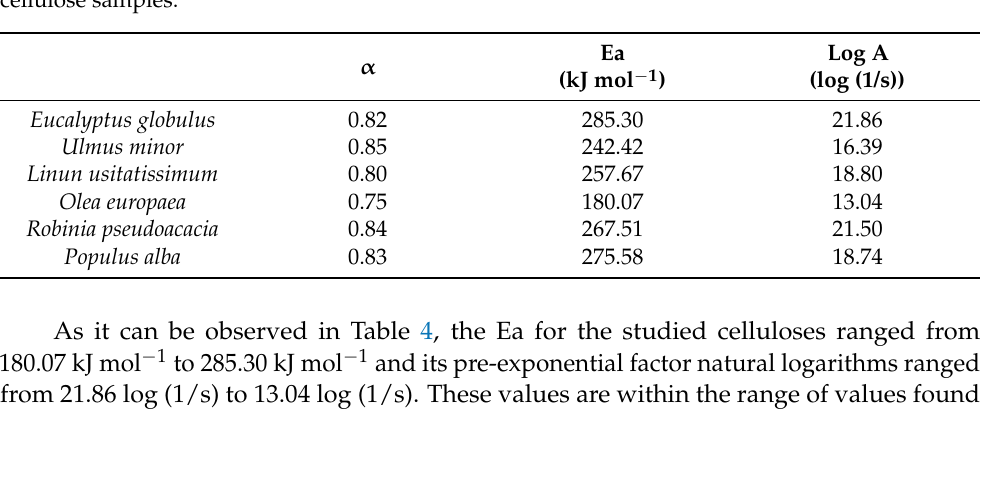
Table 4. Maxima activation energy, pre-exponential factor, and conversion degree for studied cellulose